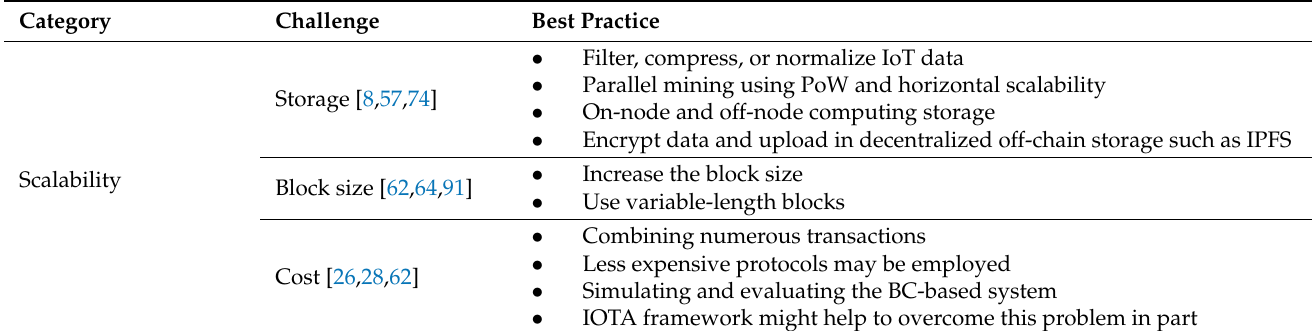
Table 9. Recommendations for reducing the negative impact of scalability